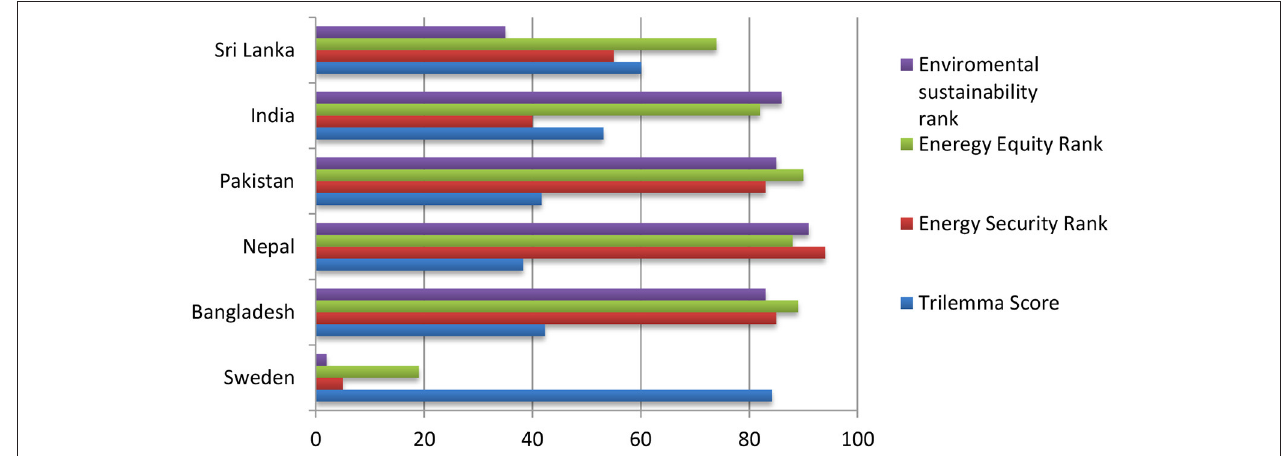
FIGURE 4 | Countries comparative chart of trilemma score.